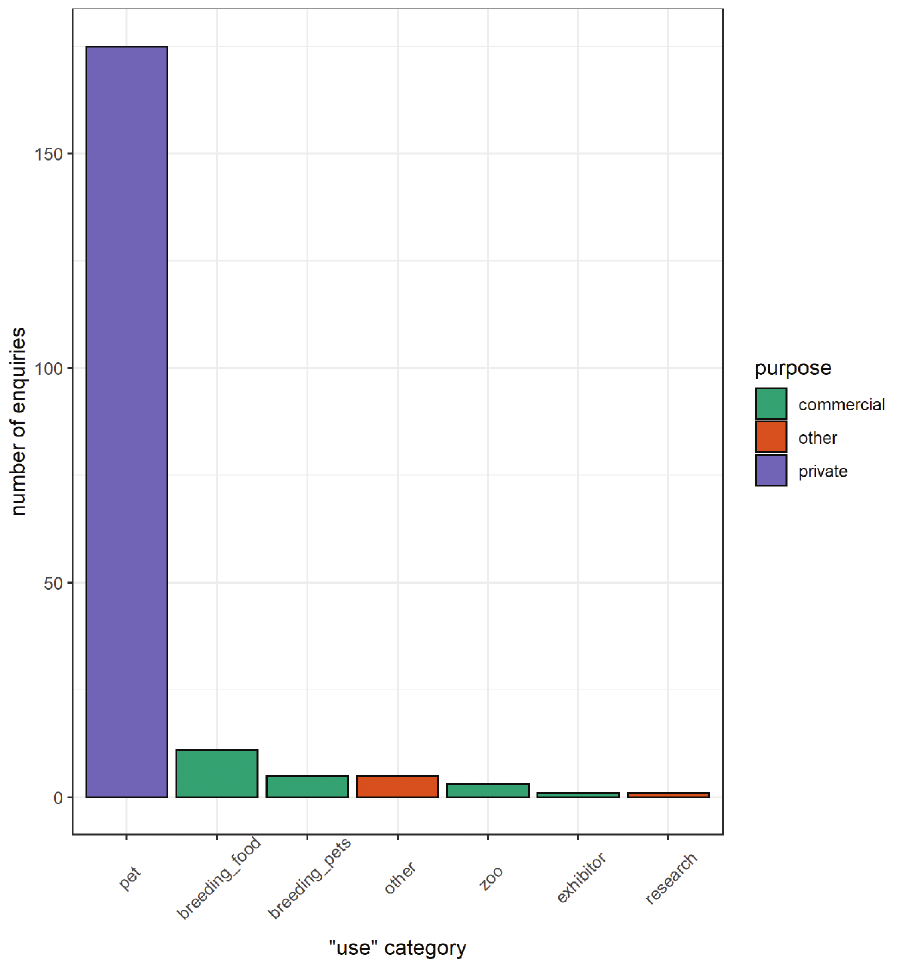
Figure 1. The stated use and purpose of public import enquiries recorded by the Australian Government Department of Agriculture, Water and the Environment. Use was categorised using enquiry notes (Pet = private use of the animal as a pet; breeding food = commercial use of the animal to be bred as food; breeding pets = commercial use of the animal to breed and sell as pets; zoo = commercial use for display in a zoo/wildlife park; exhibitor = commercial use for exhibitions/shows; research = use of the animal for scientific research; other = use not quiries, followed by parrots (Psittaciformes), then hedgehogs (Erinaceomorpha; Fig. 3b). Overall, the most enquired taxa were hedgehogs (Erinaceinae), fennec fox ( Vulpes zerda ), African grey parrot ( Psittacus erithacus ), monkeys (Simiiformes) and pygmy marmoset ( Cebuella pygmaea ; Fig. 3c). The two most commonly enquired non-vertebrate taxa were tarantula spiders (Theraphosidae, n = 14) and freshwater atyid shrimp ( Caridina , n = 5). All remaining non-vertebrate taxa (n = 3) had a single enquiry each.